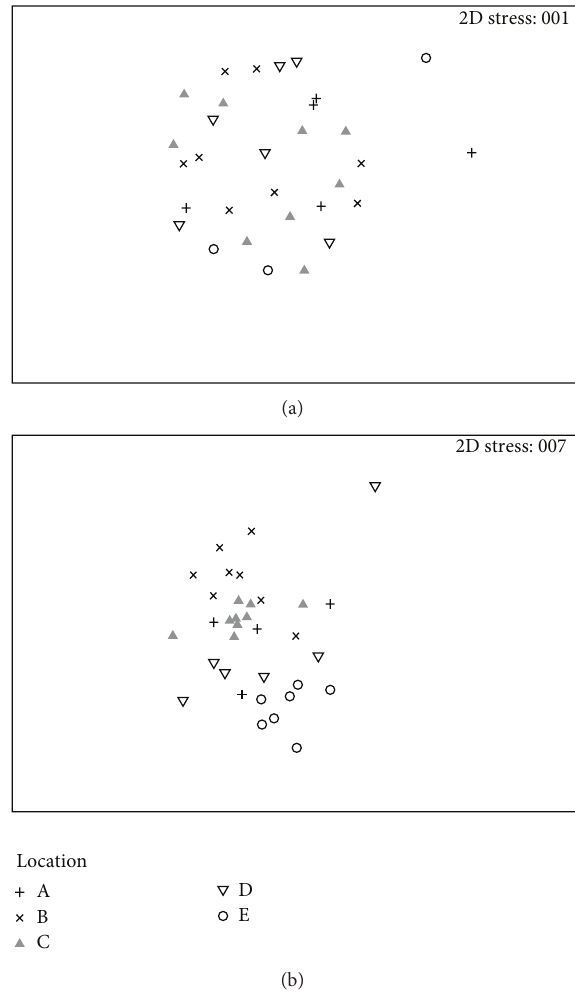
Figure 3: (a) nonmetric Multidimensional Scaling (nMDS) ordi- nation of Bray-Curtis similarities of assemblage composition of the abundant/encrusting between Locations (A–E). (b) nMDS ordinationoftheBray-Curtissimilaritiesofassemblagecomposition of the infrequent/conspicuous fauna between Locations (A–E). Data were dispersion weighted and square root